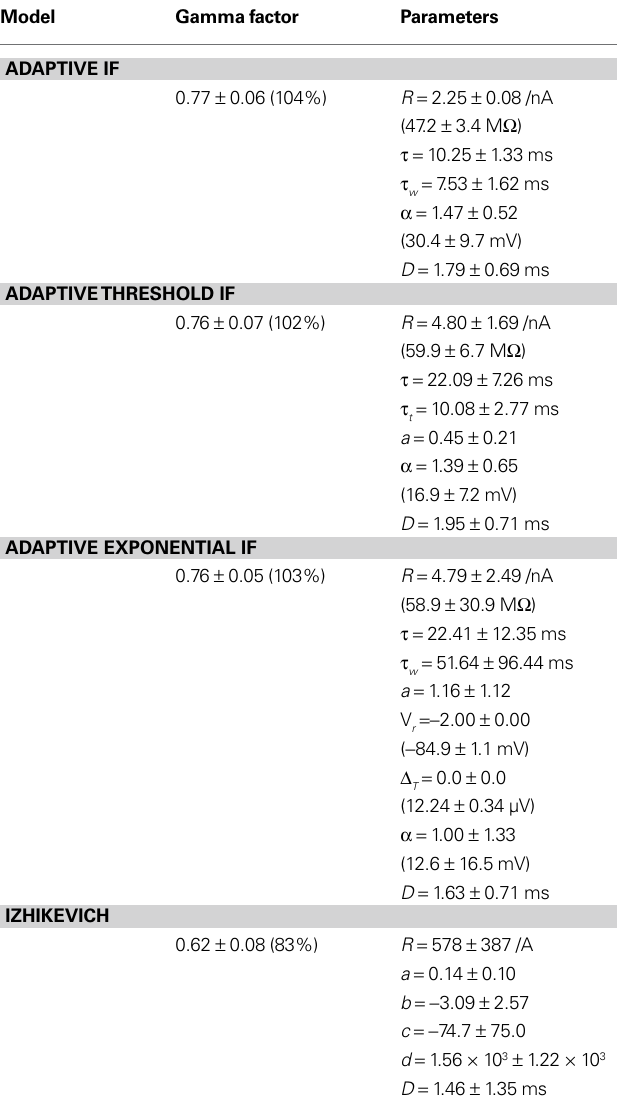
Table 2 | Optimization results for Challenge B. Four neuron models were fi tted to the electro-physiological recordings of an L5 fast spiking cell responding to in-vivo -like current injection. There were 9 trials with the same